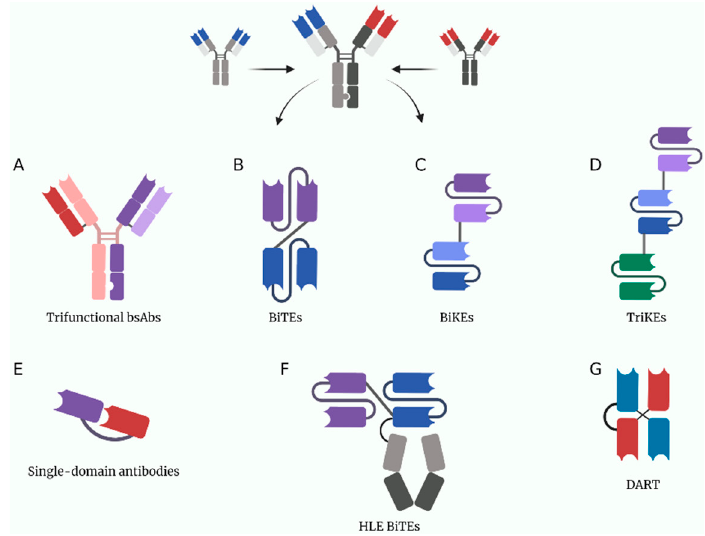
Figure 1. A depiction of some current multivalent antibody structures under study. ( A ) Trifuctional antibodies conserved their Fc domain to be able to bind to cells expressing Fc receptors. ( B ) BiTEs (bispecific T-cell engagers). ( C ) BiKEs (bispecific NK-cell engagers). ( D ) TriKEs (trispecific NK-cell engagers). ( E ) Single-domain antibodies only have one variable chain per target, they are usually made from heavy chain nanobodies derived from the structure of heavy-chain only camelid antibodies. ( F ) HLE BiTEs (half-life extended bispecific T-cell engagers) are BiTEs with an Fc portion that increases its half-life. ( G ) DARTs (dual affinity retargeting antibodies). Created with BioRender.com.